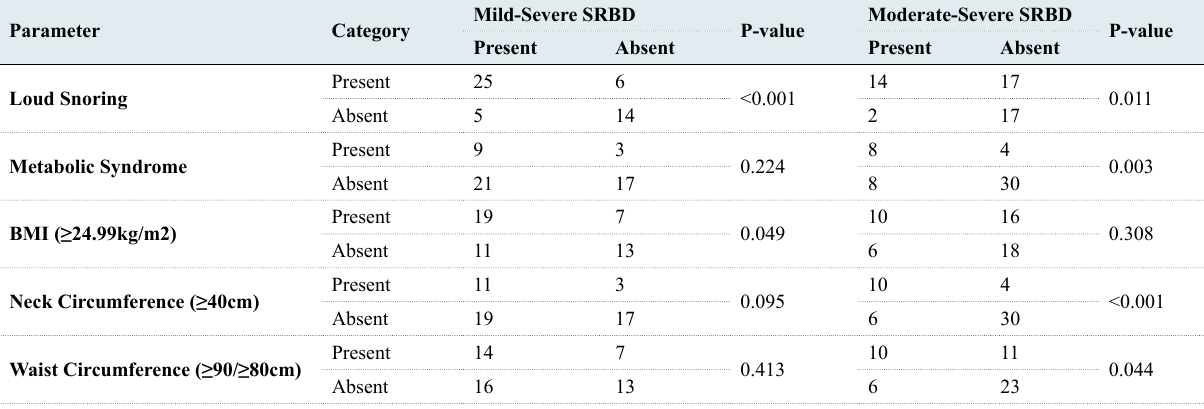
Table 2: Clinical and Anthropometric Predictors of SRBD in patients with Respiratory Symptom Complex